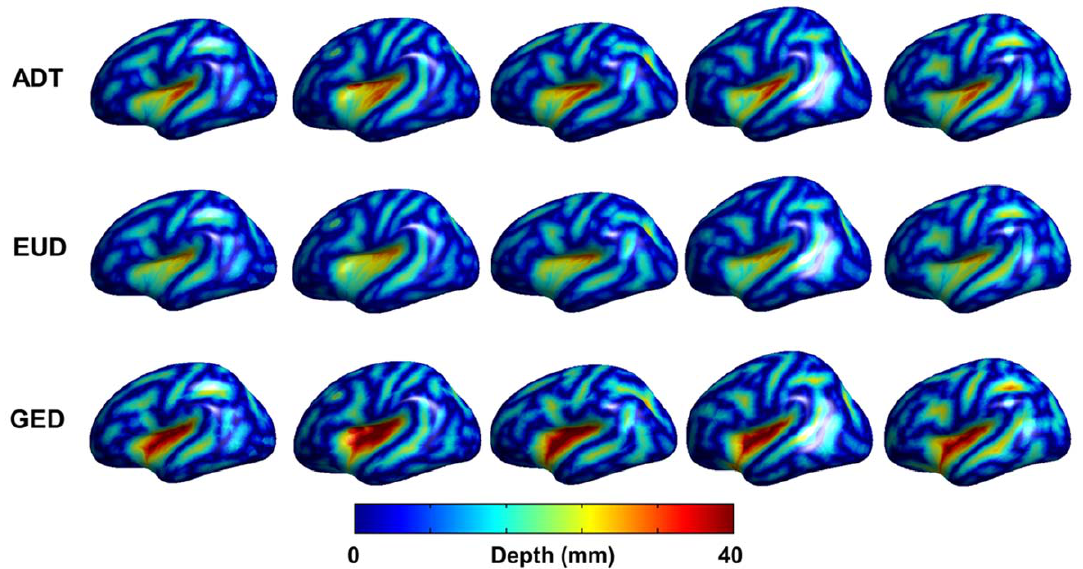
Figure 6. An example of the differences among the algorithms in the 5 subjects.